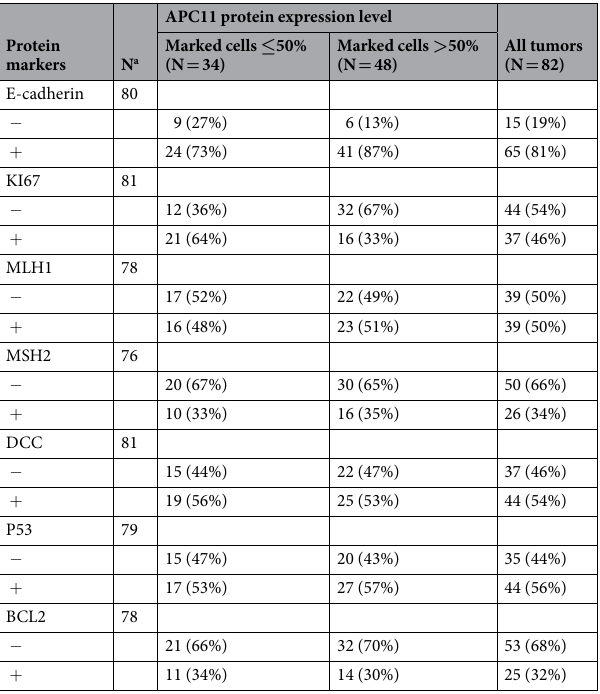
Table 2. Immunohistochemistry characterization of the 82 colorectal cancer tissues, stratified by APC11 protein expression level. a Number of patients with available